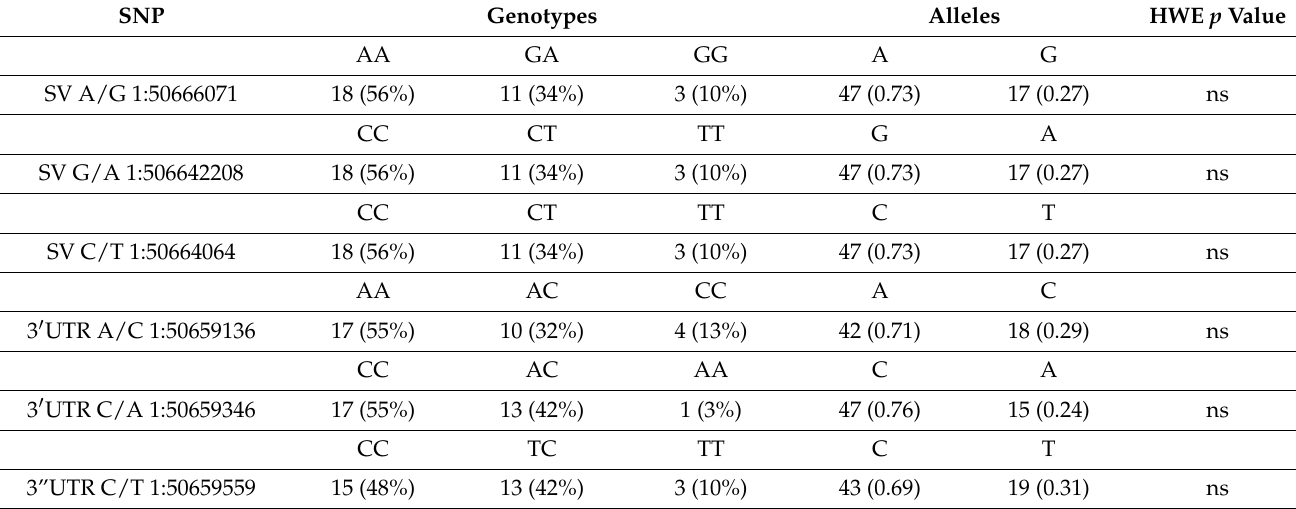
Table 6. The genotype distribution for SNPs detected in TLR8 gene.